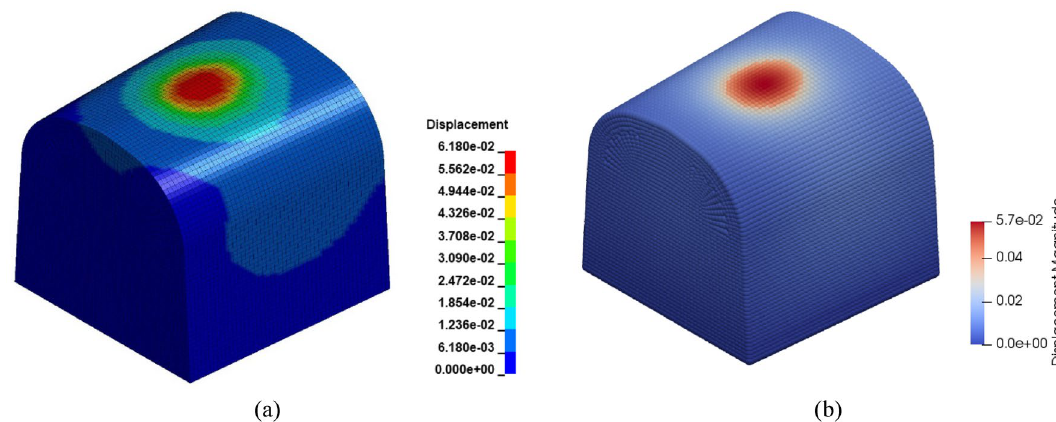
Figure 4. Numerical geometries, ( a ) FEM ( b ) PD. The magnitudes are in